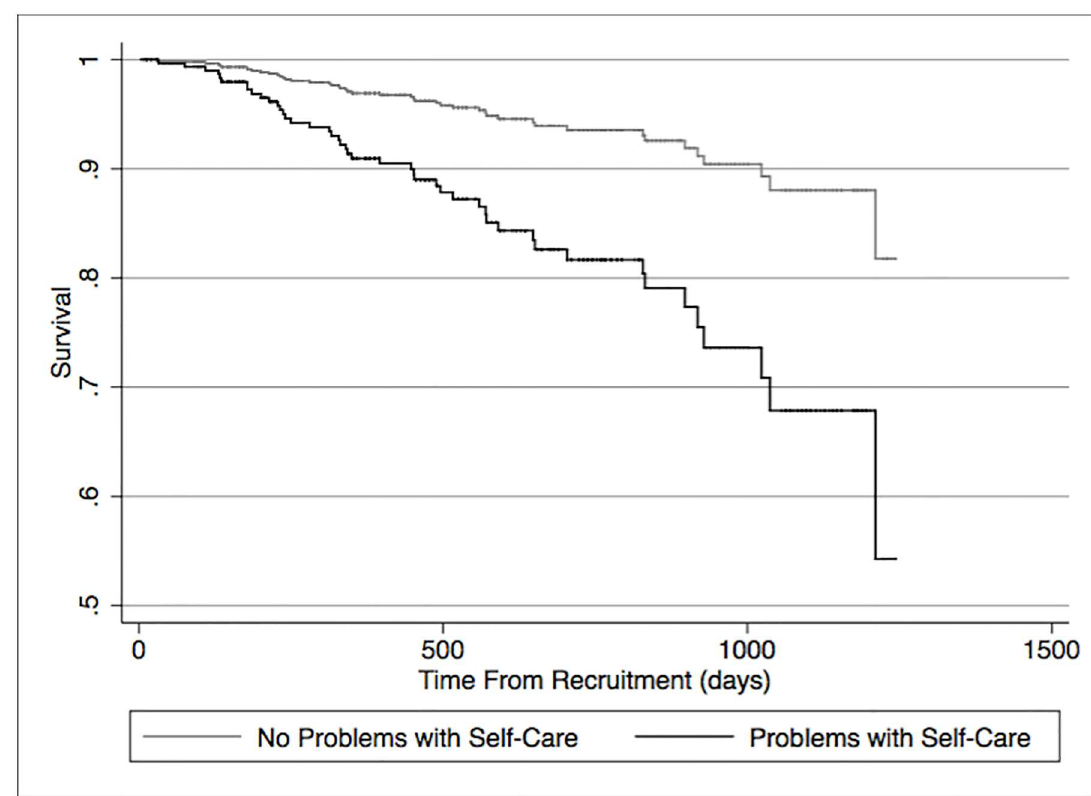
Fig 3. Cox Proportional HazardsRegression for reported problems with self-care and death. UnivariableAnalyses.